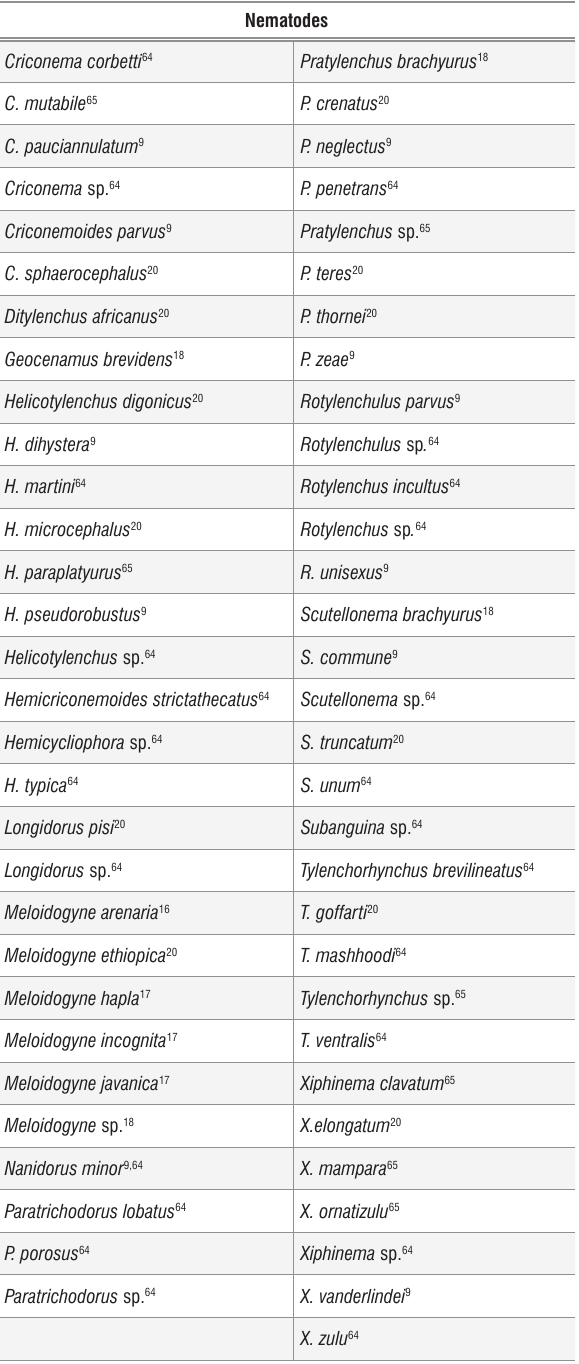
Plant-parasitic nematodes associated with soybean in